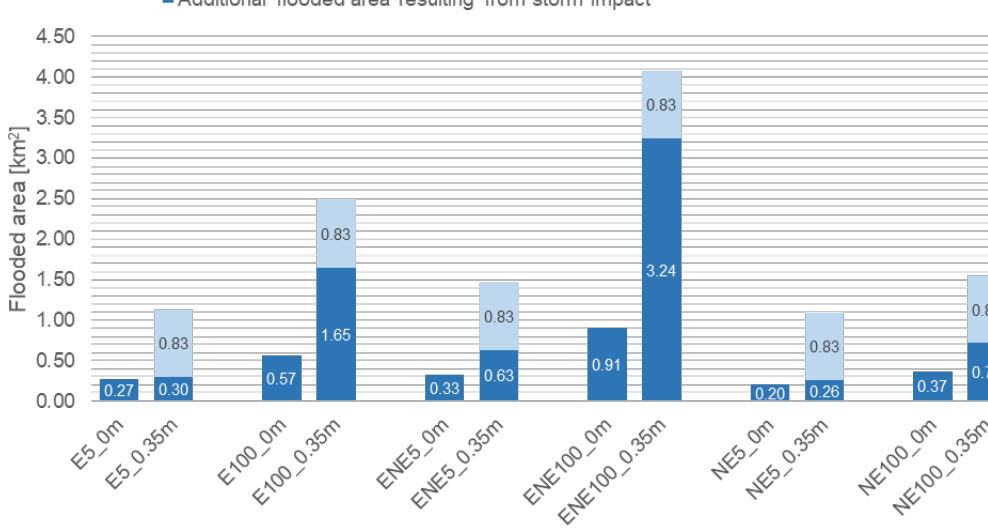
Figure 6. Flooded area compared to that in which no flood situation is associated to present climate scenarios for each of the studied combinations of storm direction, return period and sea level (legend: [storm direction] [return period] _ [sea level]). The total flooded area is divided into the static contribution of relative sea level and the increase of the inundated area due to wave impact and its associated processes (dune erosion, overwash, etc.).